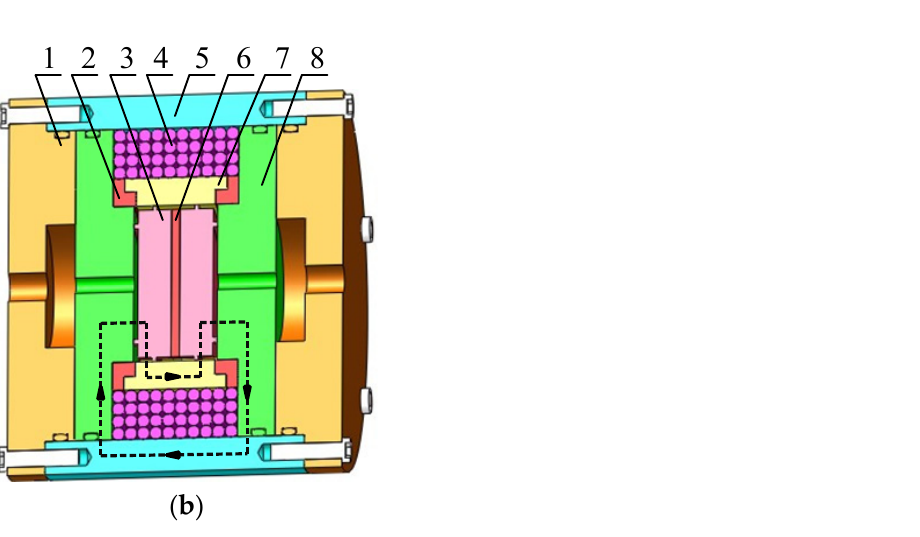
Figure 1. Schematic configuration of the enhanced radial MR valve: ( a ) Schematic diagram, ( b ) 3D diagram. 1. End cover, 2. Nonmagnetic ring, 3. Damping disk, 4. Excitation coil, 5. Valve body, 6. Nonmagnetic disk, 7. Magnetic ring, 8. Positioning plate.